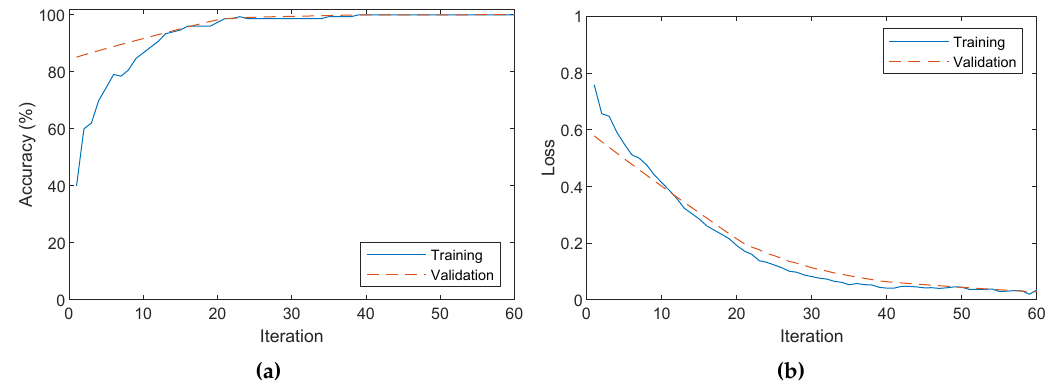
Figure 13. Result of the training of the deep neural model. ( a ) Accuracy, ( b )